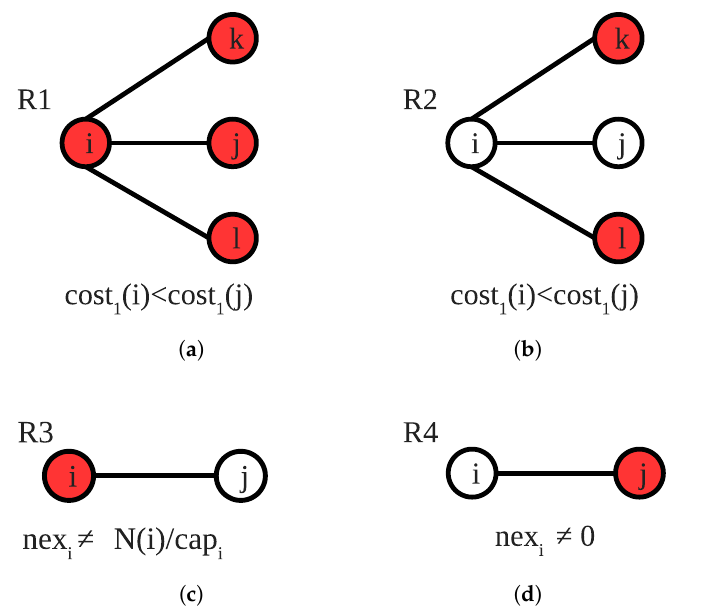
Figure 2. Sample scenarios for rules of SS-CVC 1 : ( a ) An Example for R1; ( b ) An Example for R2; ( c ) An Example for R3; ( d ) An Example for